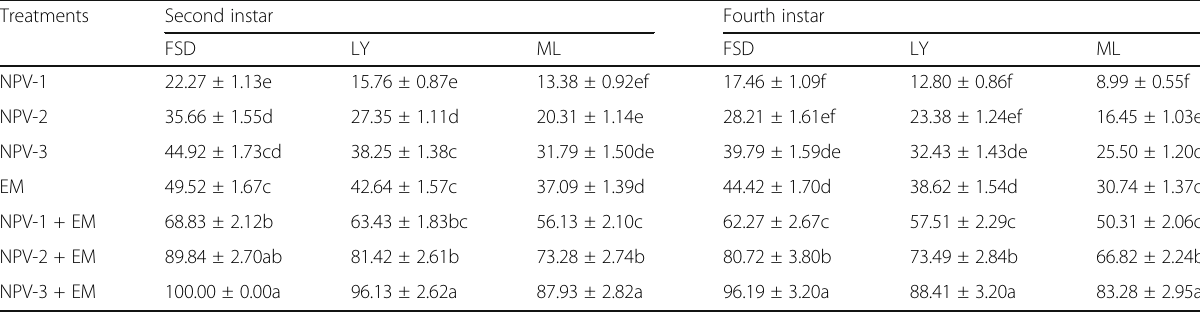
Mean sharing the same letters within each column are not significantly different at 1.0% level